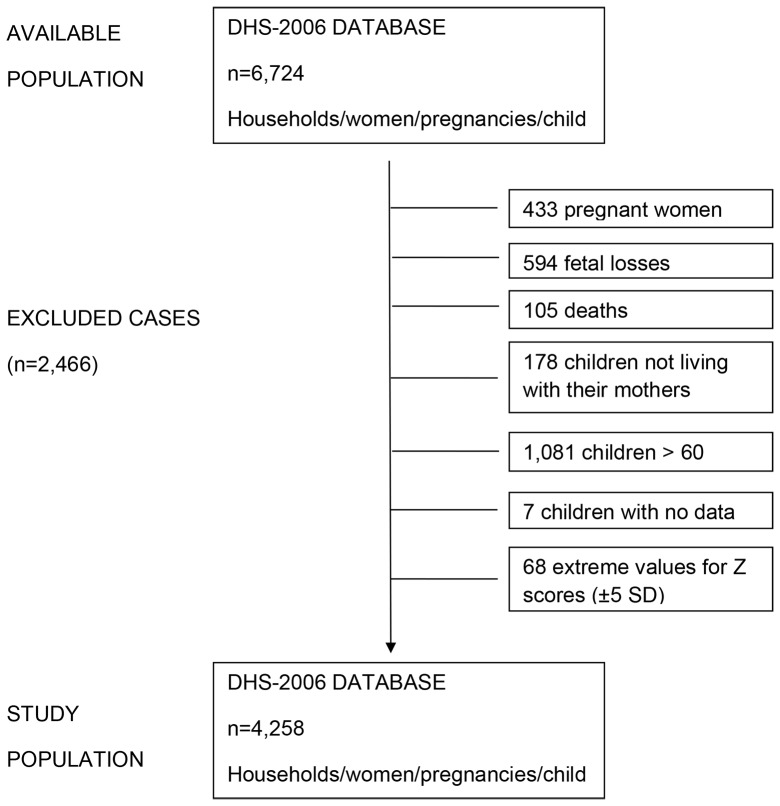
Study population diagram.